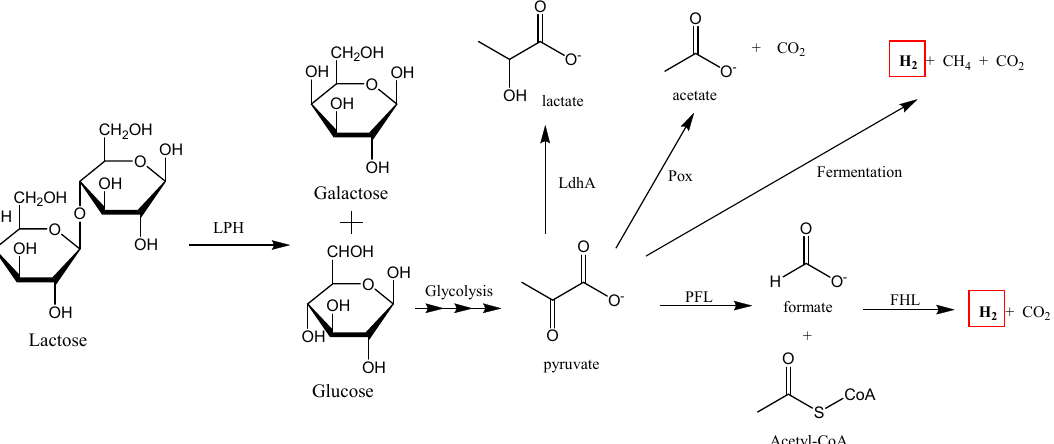
Figure 3. Colonic metabolism of lactose by Escherichia coli . Gases such as hydrogen, methane, and carbon dioxide are formed as products (modified from [27,30]). Red frame delineates H 2 production.